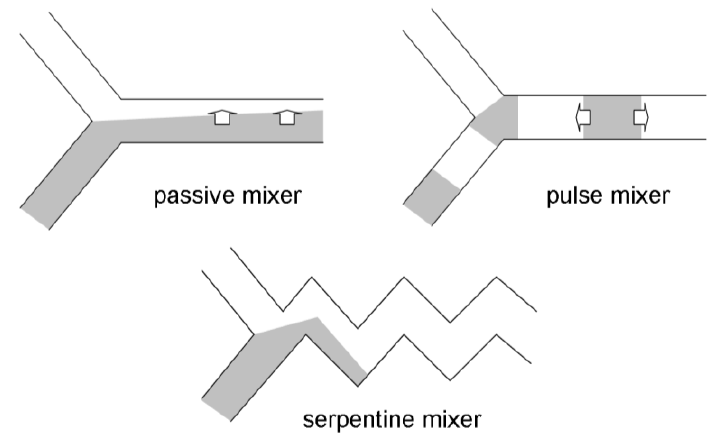
purely by perpendicular diffusion. Pulse mixer: the fluid is supplied with pulse flow,